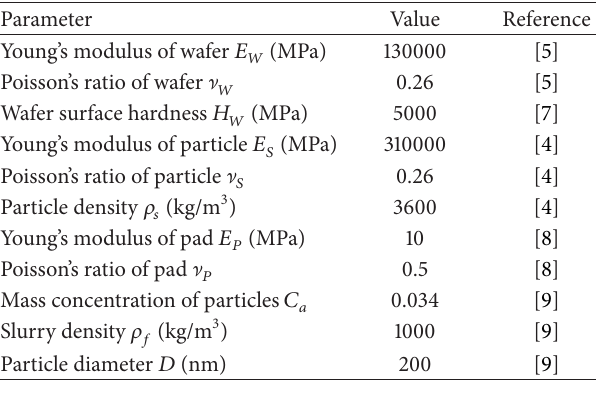
Table 2: Parameters calculating forces between wafer and abrasive.